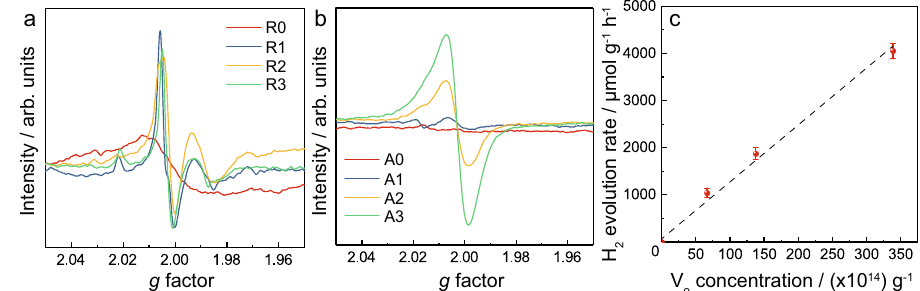
Fig. 3 EPR spectra and their hydrogen evolution activity of rutile and anatase materials. EPR spectra for ( a ) rutile and ( b ) anatase materials. c Hydrogen evolution of anatase catalysts under visible light against EPR-derived oxygen vacancy concentration. Error bars indicate the standard deviation.